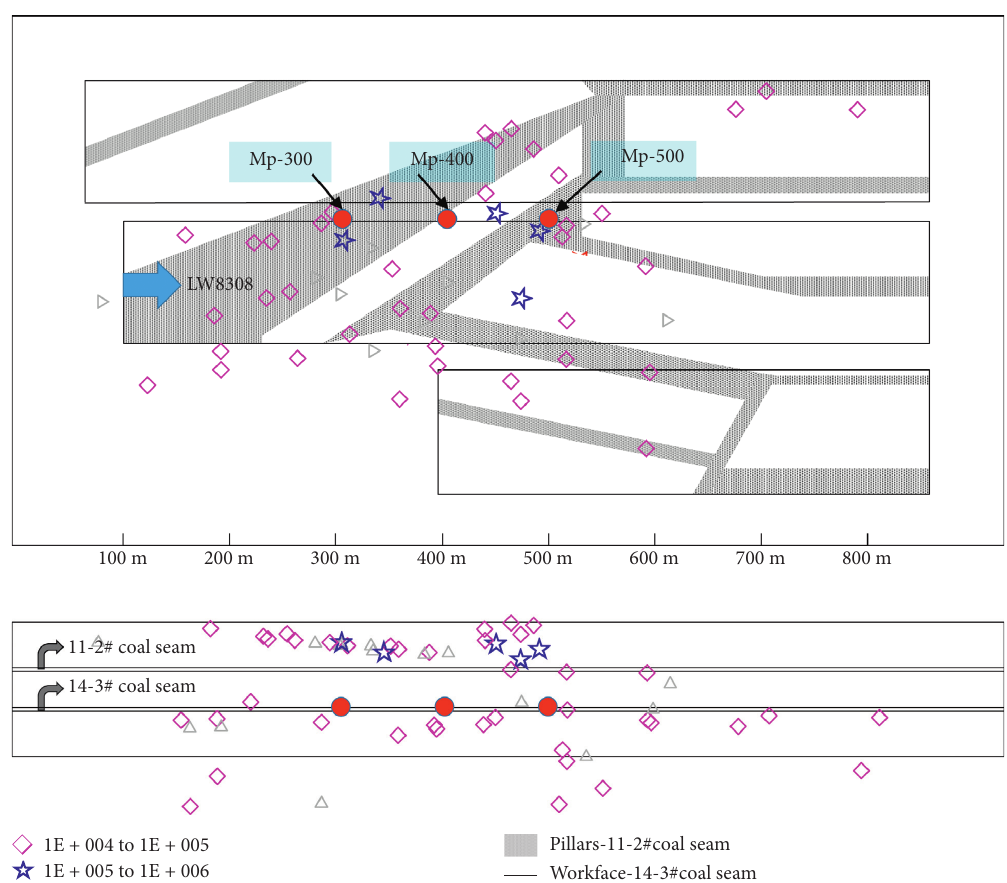
Figure 13: (a) Location map of the horizontal profile of microseismic events. (b) Location map of microseismic events along strike